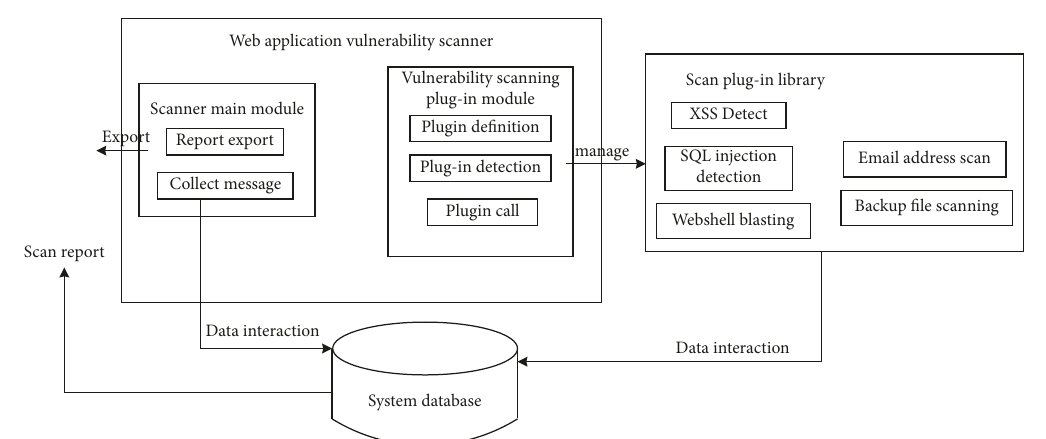
Figure 1: Basic structure of web application vulnerability